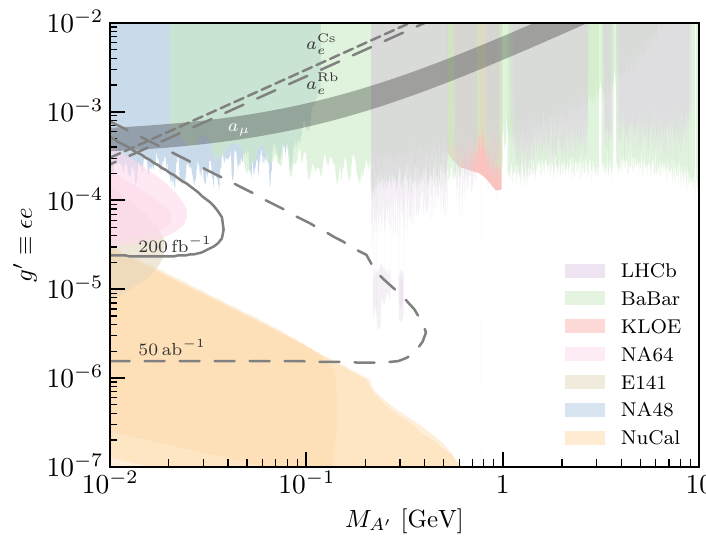
Figure 5 . The dashed grey line demarcates the outer boundaries of the projected limits for Belle II sensitivity to displaced searches for the dark photon model at an integrated luminosity of 50 ab -1 , with the dark photon decaying to a lepton pair ( e or µ ). The solid grey line indicates the same but for an integrated luminosity of 200 fb -1 . The regions shaded in different colors reflect bounds from existing experiments, with the colors used for different experiments indicated in the legend. The regions of parameter space consistent with the latest measurement of ∆ a µ has been shaded in grey and labelled. Also shown are the contours which satisfy the a e measurements using Rb and